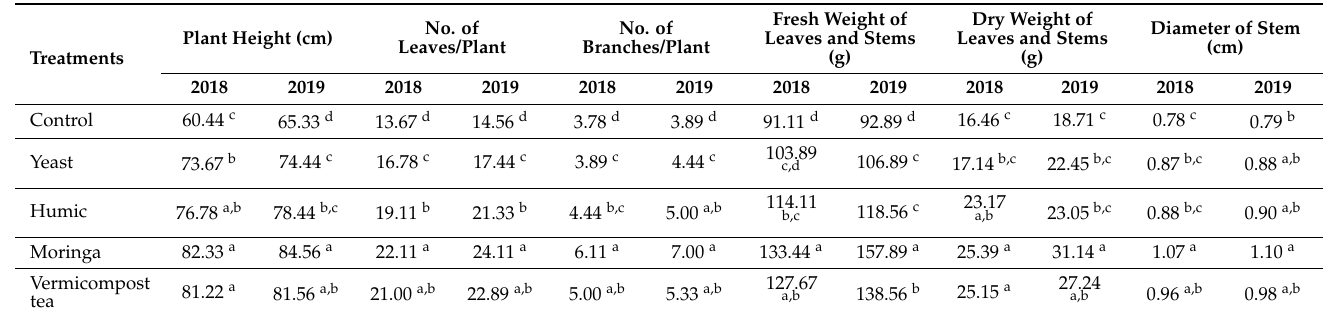
Table 5. Influence of different biostimulant extracts on vegetative growth characteristics of green bean (65 days after sowing) in the growing seasons of 2018 and